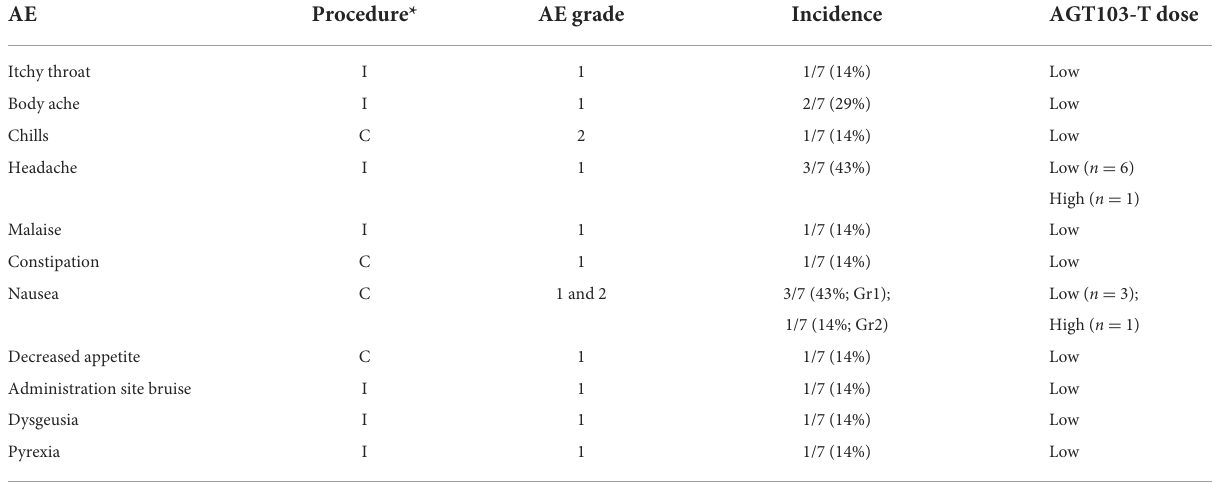
TABLE 4 Adverse events.